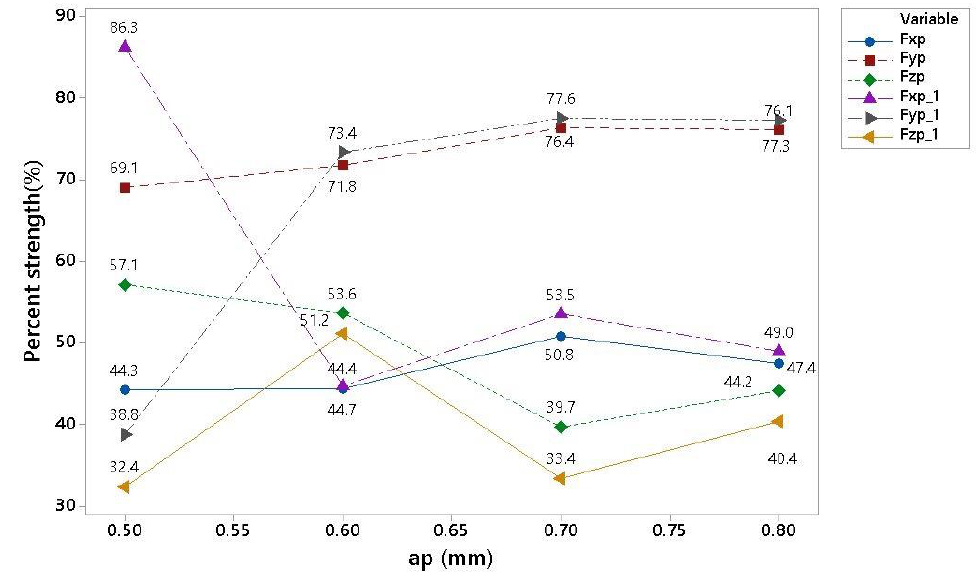
Figure 7. Graphical comparison of the results for two cutting conditions.